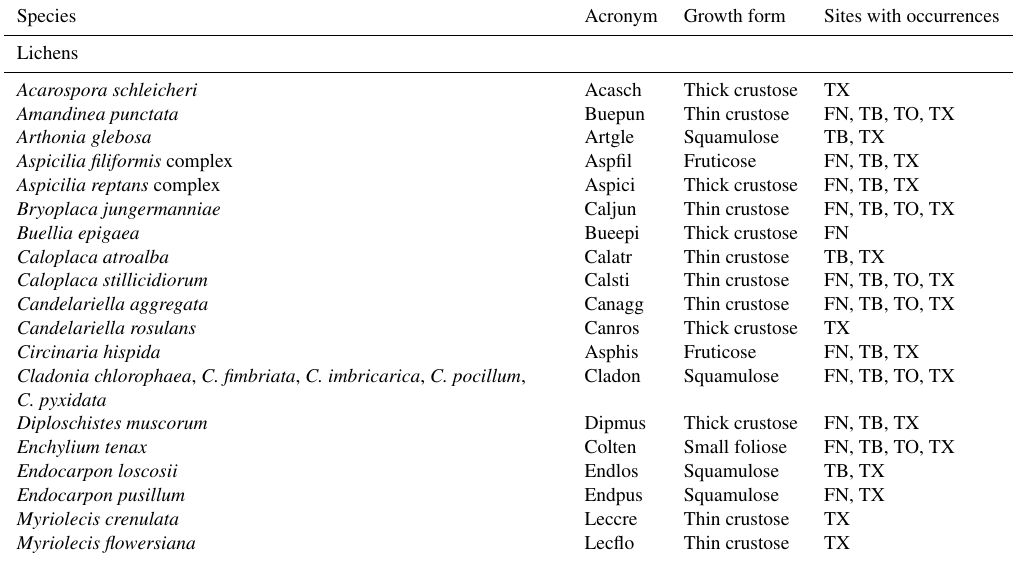
Table A1. Biological soil crust lichen and bryophyte species found in burned and unburned plots at the sites of four fires in Idaho, USA. Acronyms used in analysis and growth form designation for analysis. Sites with occurrences are abbreviated (TB: Table Mountain; TO: Tobias; TX: Texas; FN: